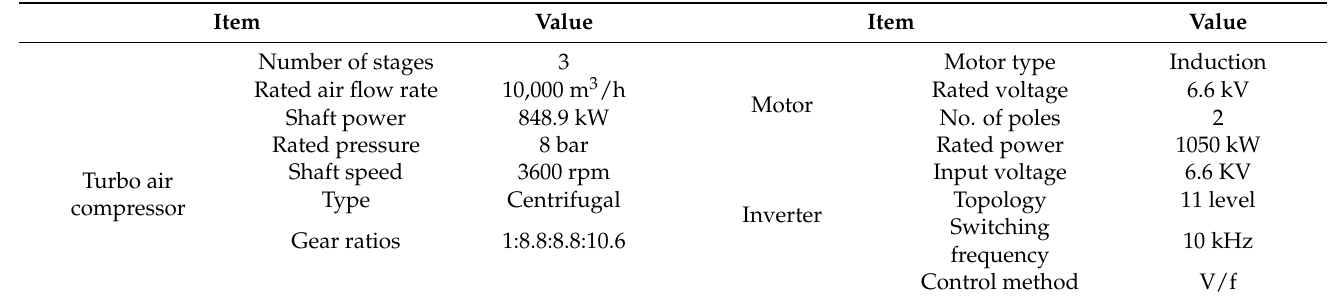
Table 1. Specifications of a TACCS